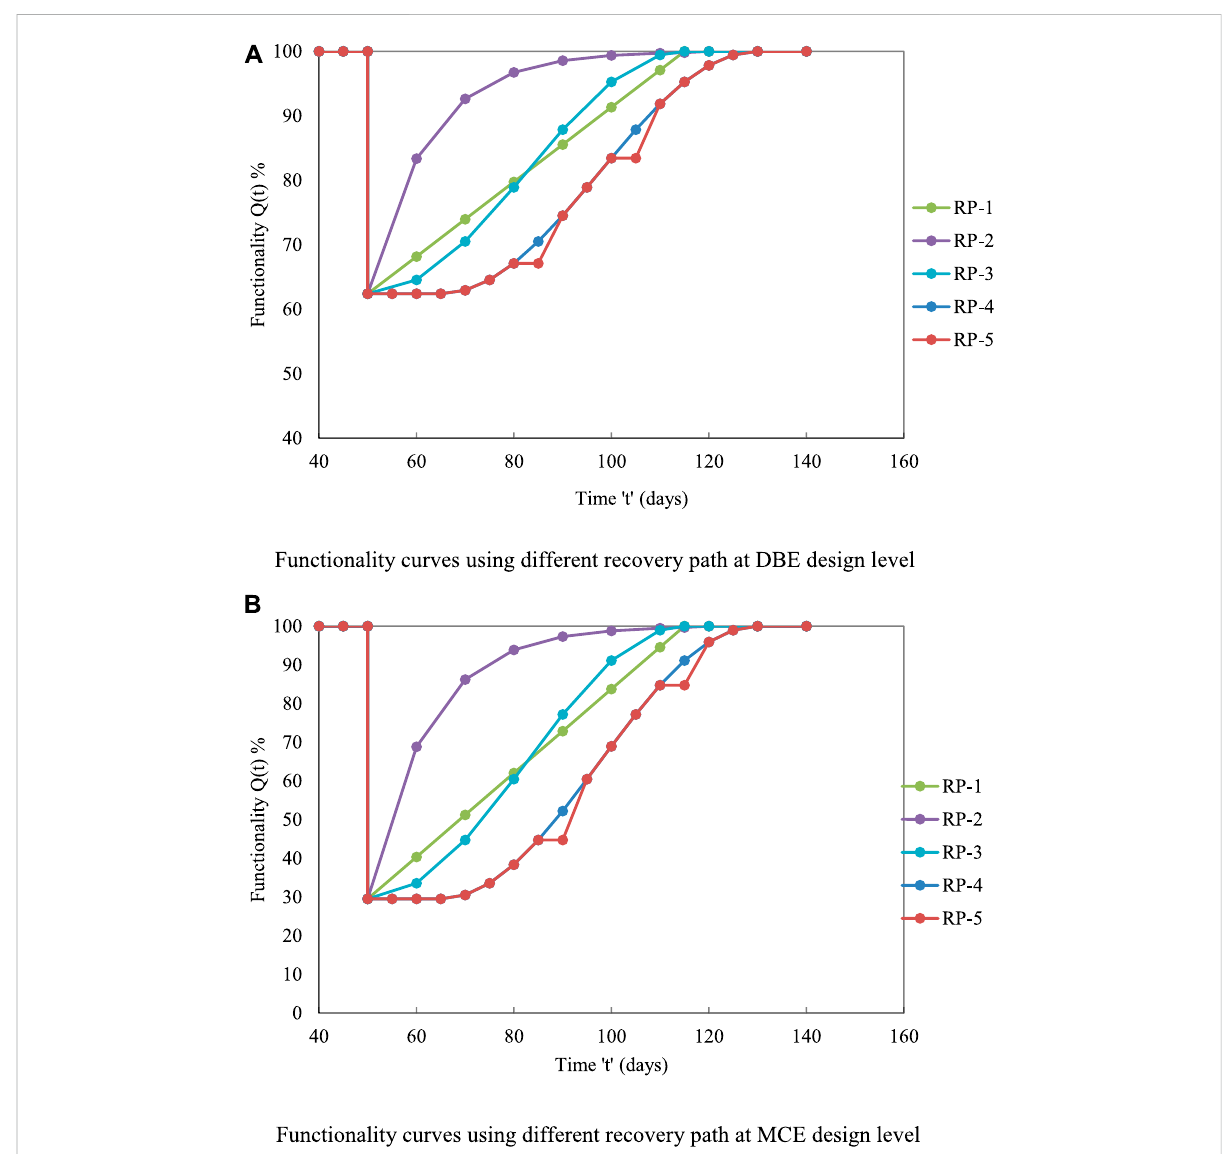
FIGURE 8 Functionality curves for case II building with respect to various recovery paths. (A) Functionality curves using different recovery paths at DBE design level. (B) Functionality curves using different recovery paths at MCE design level.